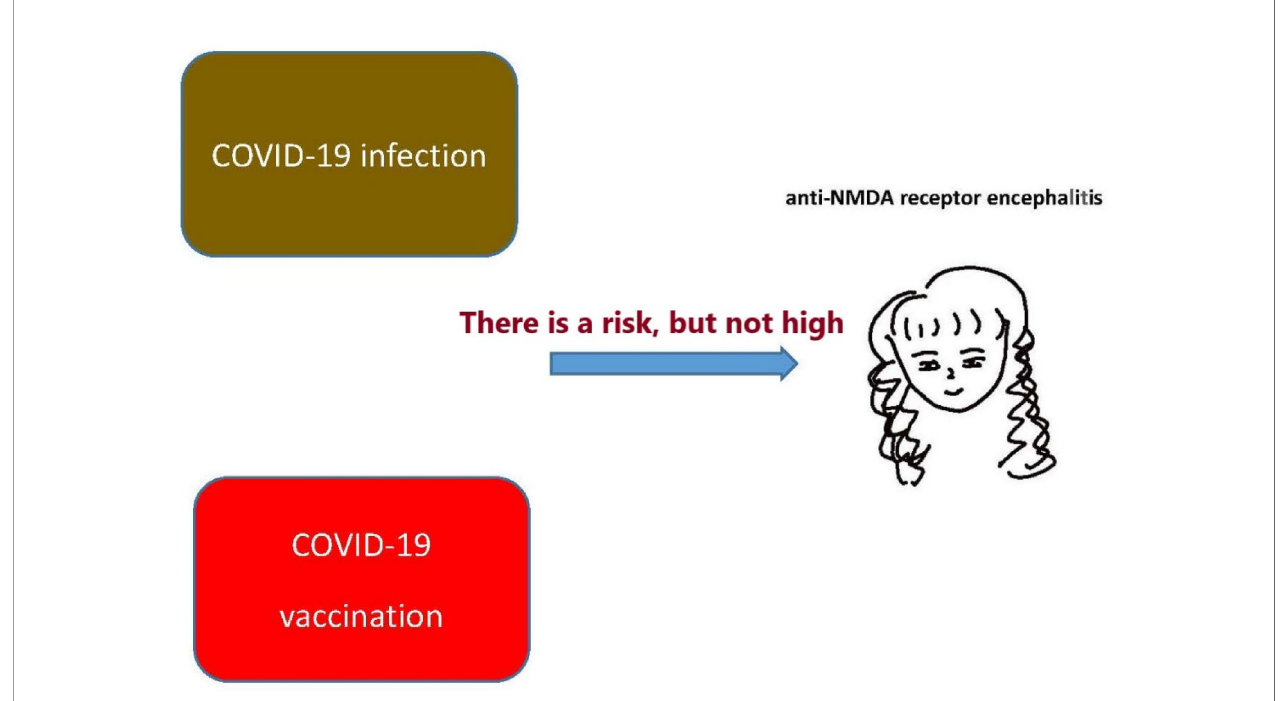
FIGURE 3 | COVID-19 infection or COVID-19 vaccination has a risk of triggering anti-NMDA receptor encephalitis, but the risk is not